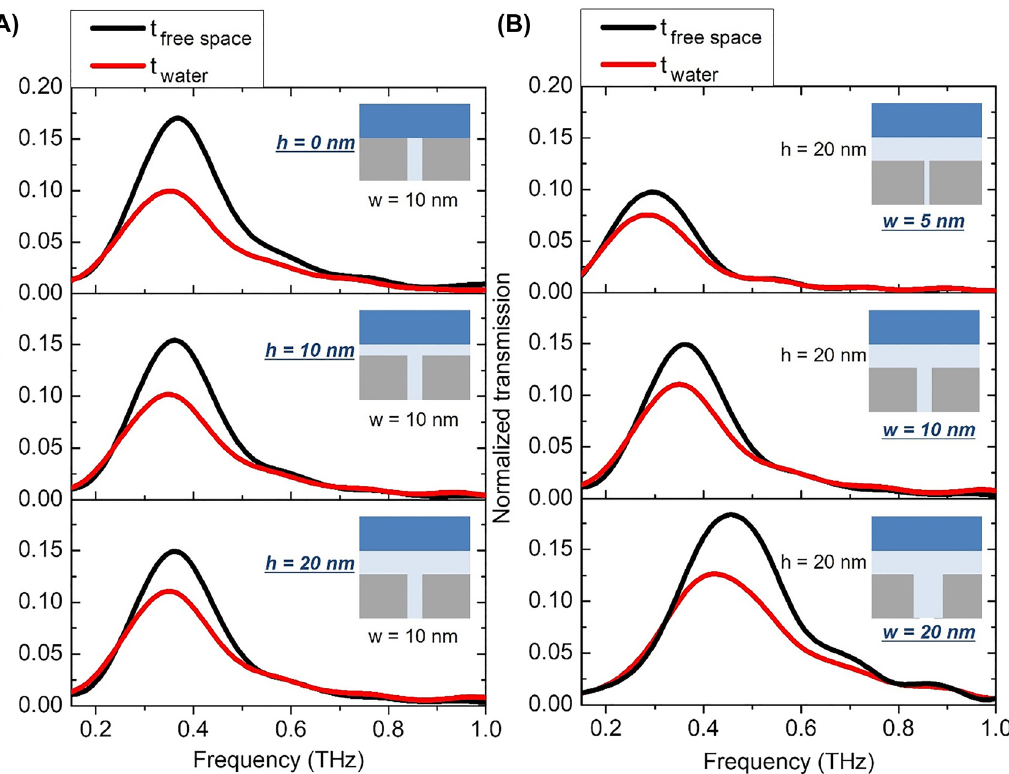
Figure 4: Normalized transmission spectra of (A) 10 nm-wide gap sample with varying gap-water distances of 0, 10, and 20 nm, and (B) 5, 10, and 20 nm-wide gap samples with a fixed gap-water distance of 20 nm. Here the normalized values are in terms of intensity rather than field amplitude, for more direct conversion into absorption in next